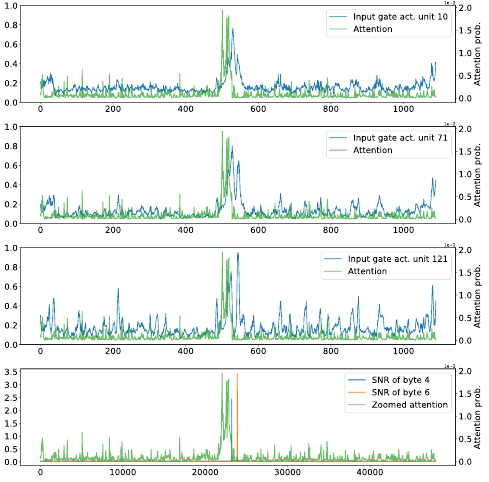
Figure 20: Activations of the input gates in a backward LSTM. The attention probabilities and SNRs are also given to investigate the